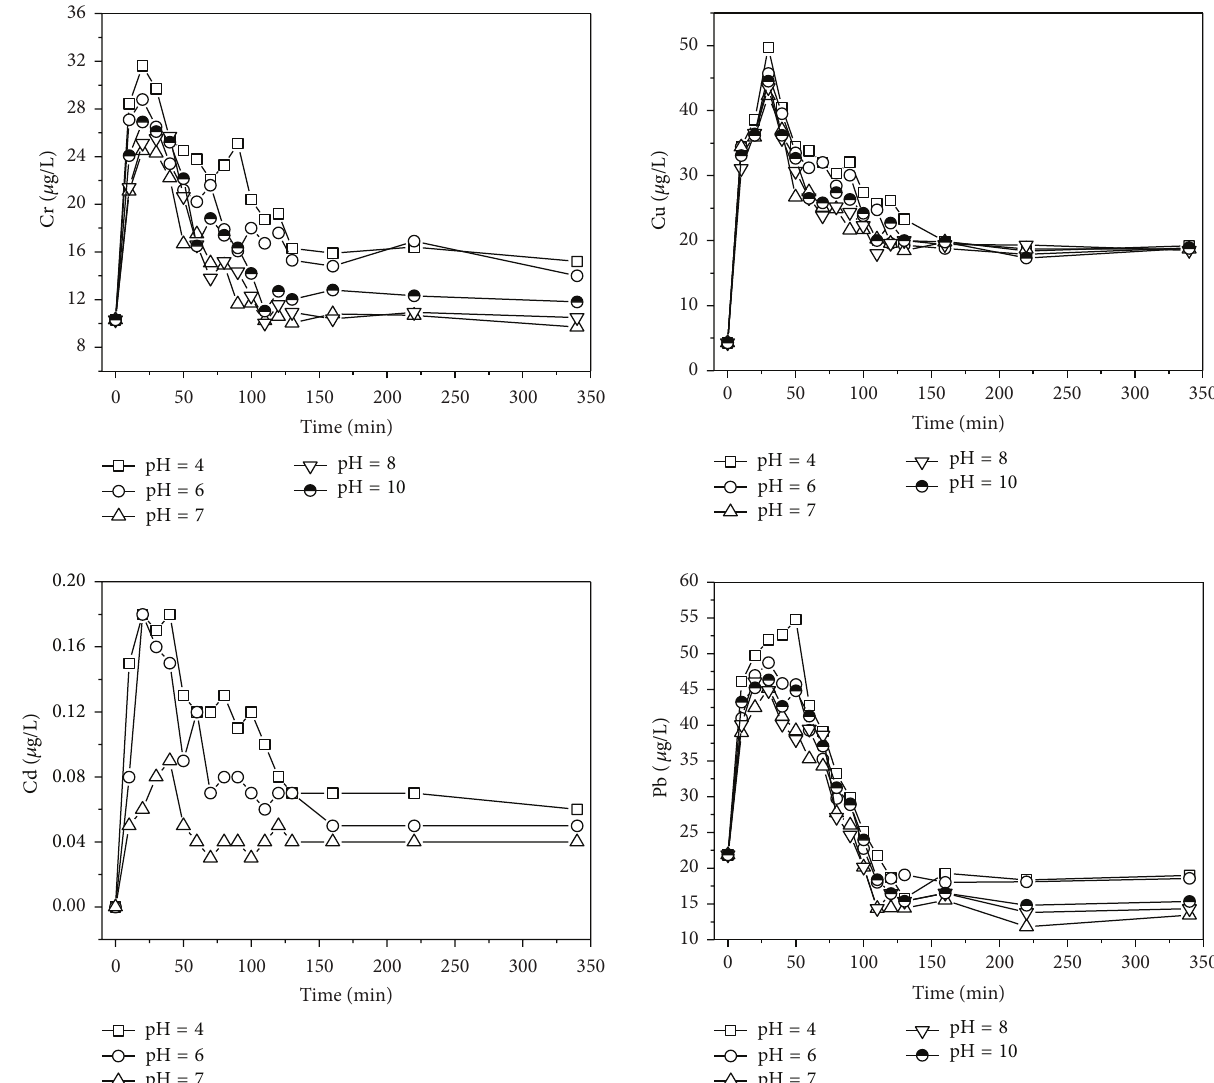
Figure 3: The concentration of Cr, Cu, Cd, and Pb in the overlying water changed with